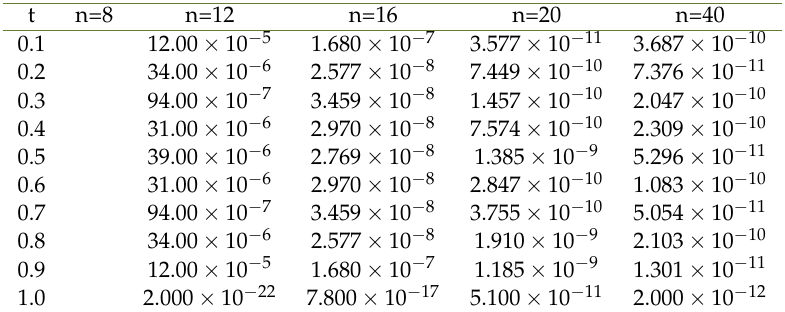
Table 2. The absolute errors | e N ( t ) | for Example 2, for n = 8, n = 12, n = 16 and n = 20.